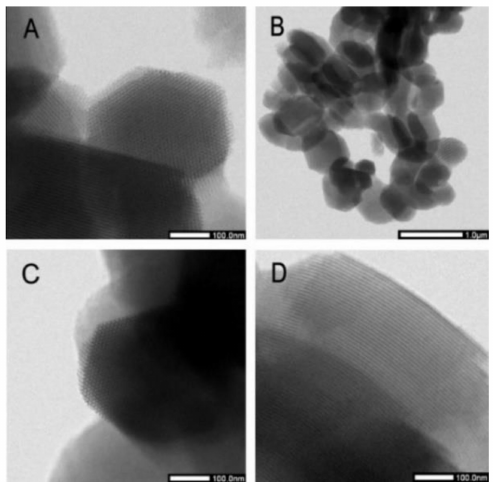
Figure 4. HRTEM images of SBA-15 ( A , B ) and C-SBA-15 ( C , D ).